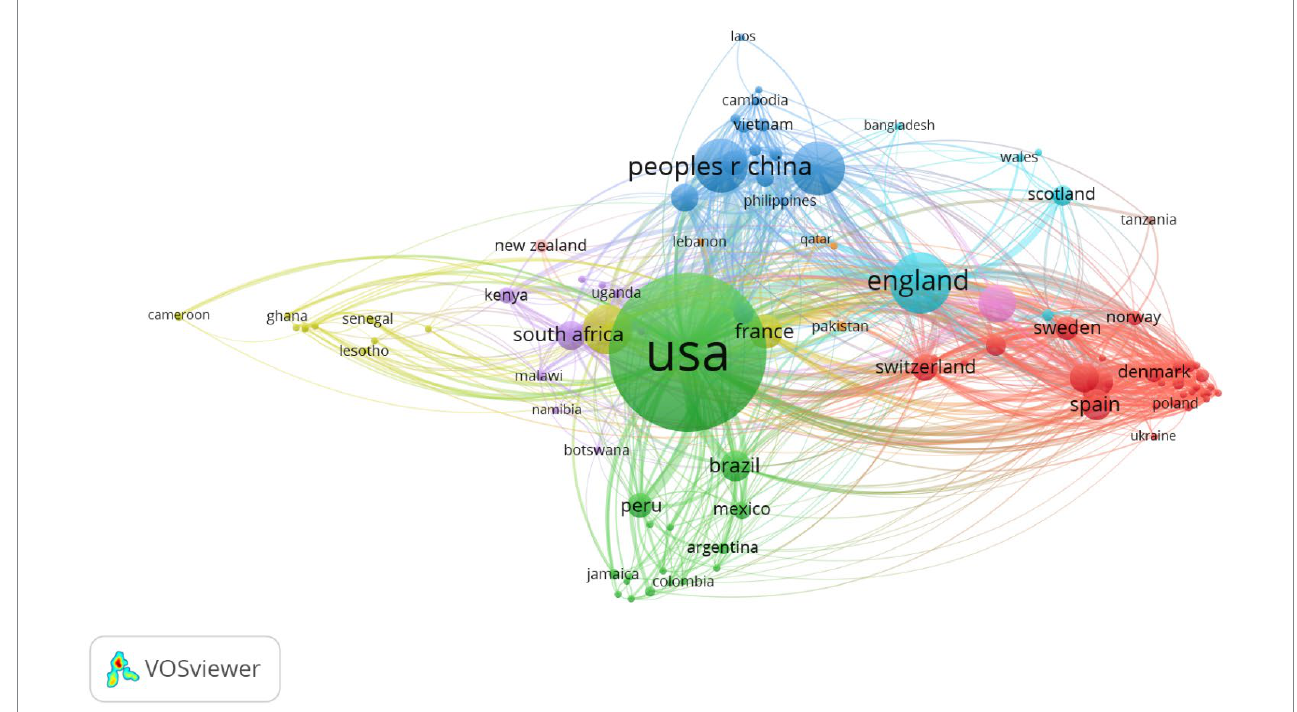
FIGURE 3 Collaborations between